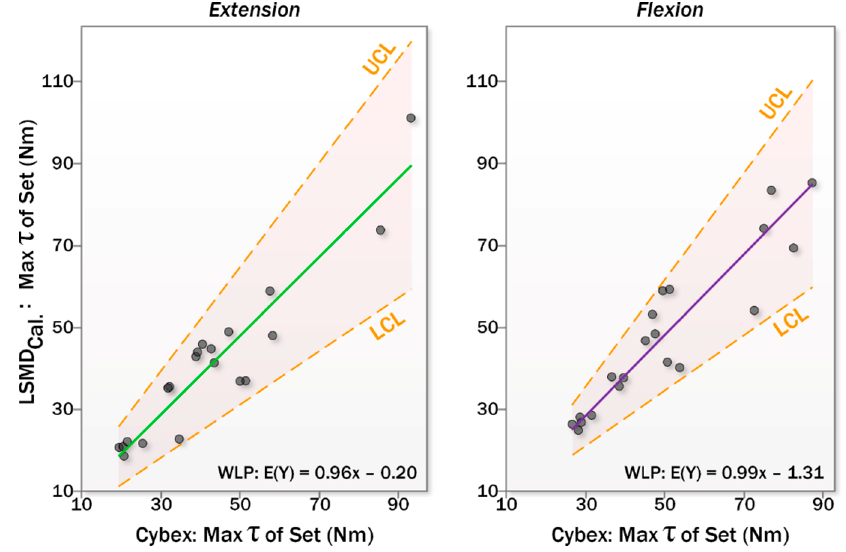
Figure 6. Limits of agreement plots for LSDM relative to IKD for extensors ( left ) and flexors ( right ).